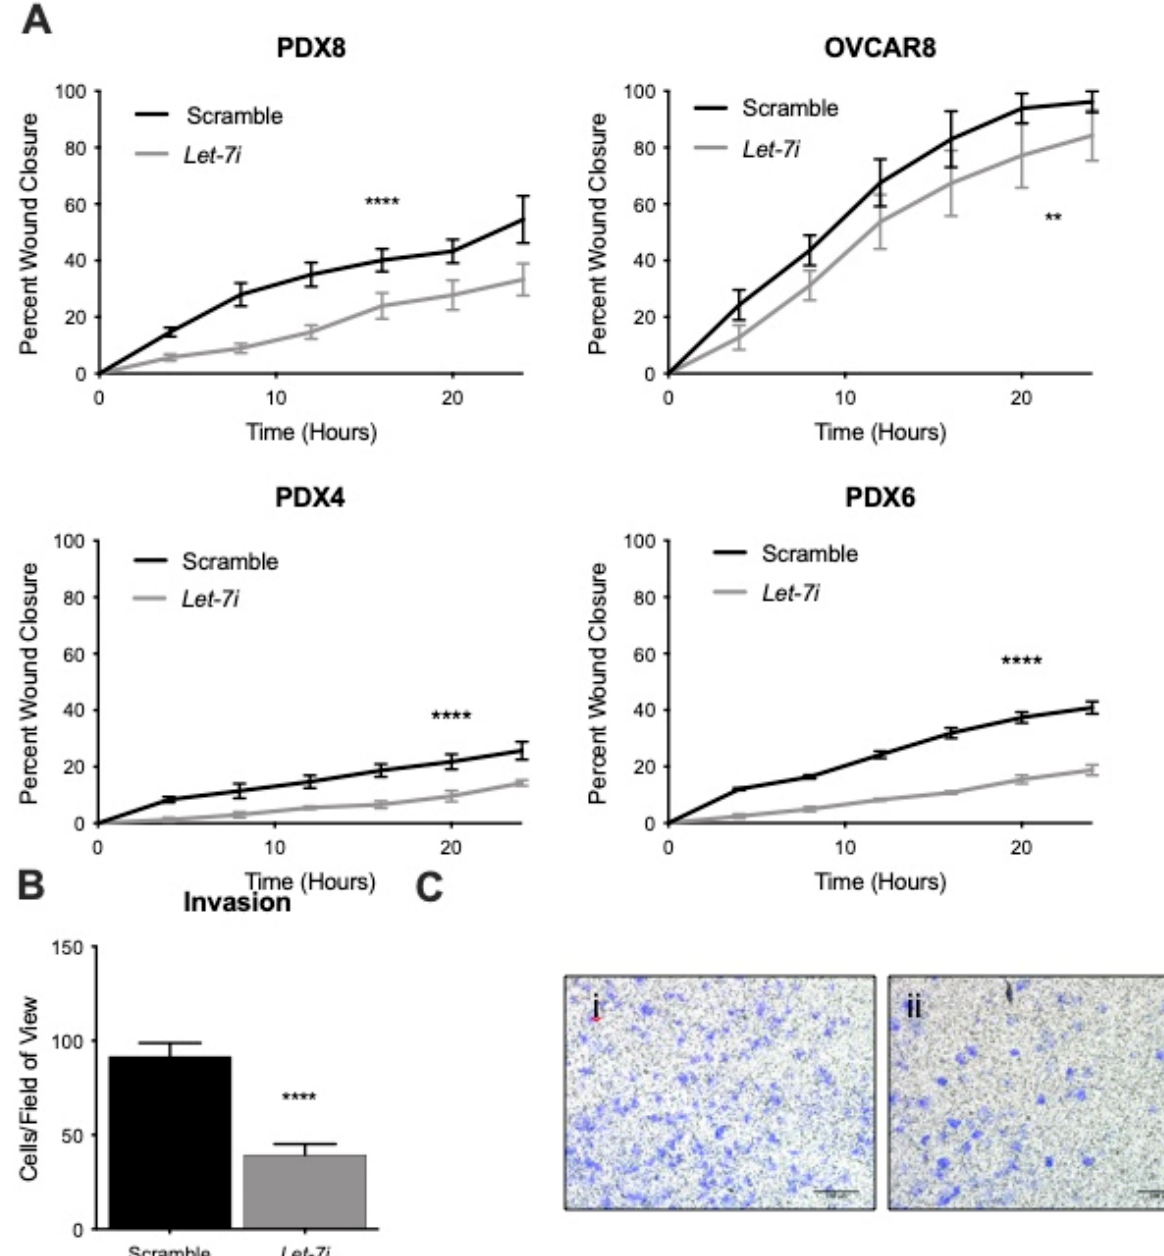
Figure 3. Let-7 reduces migration and invasion. Let-7 up-regulation demonstrates reduced ability to migrate ( A ) and invade ( B , C ). N = 3+ independent replicates. ( C ) i and ii represent Scramble and Let-7i , respectively. N = 3 independent replicates. Scale bar: 100 µm. Error bars: SEM. ** p ≤ 0.01, **** p ≤ 0.0001. p value ≤ 0.05 was considered significant.